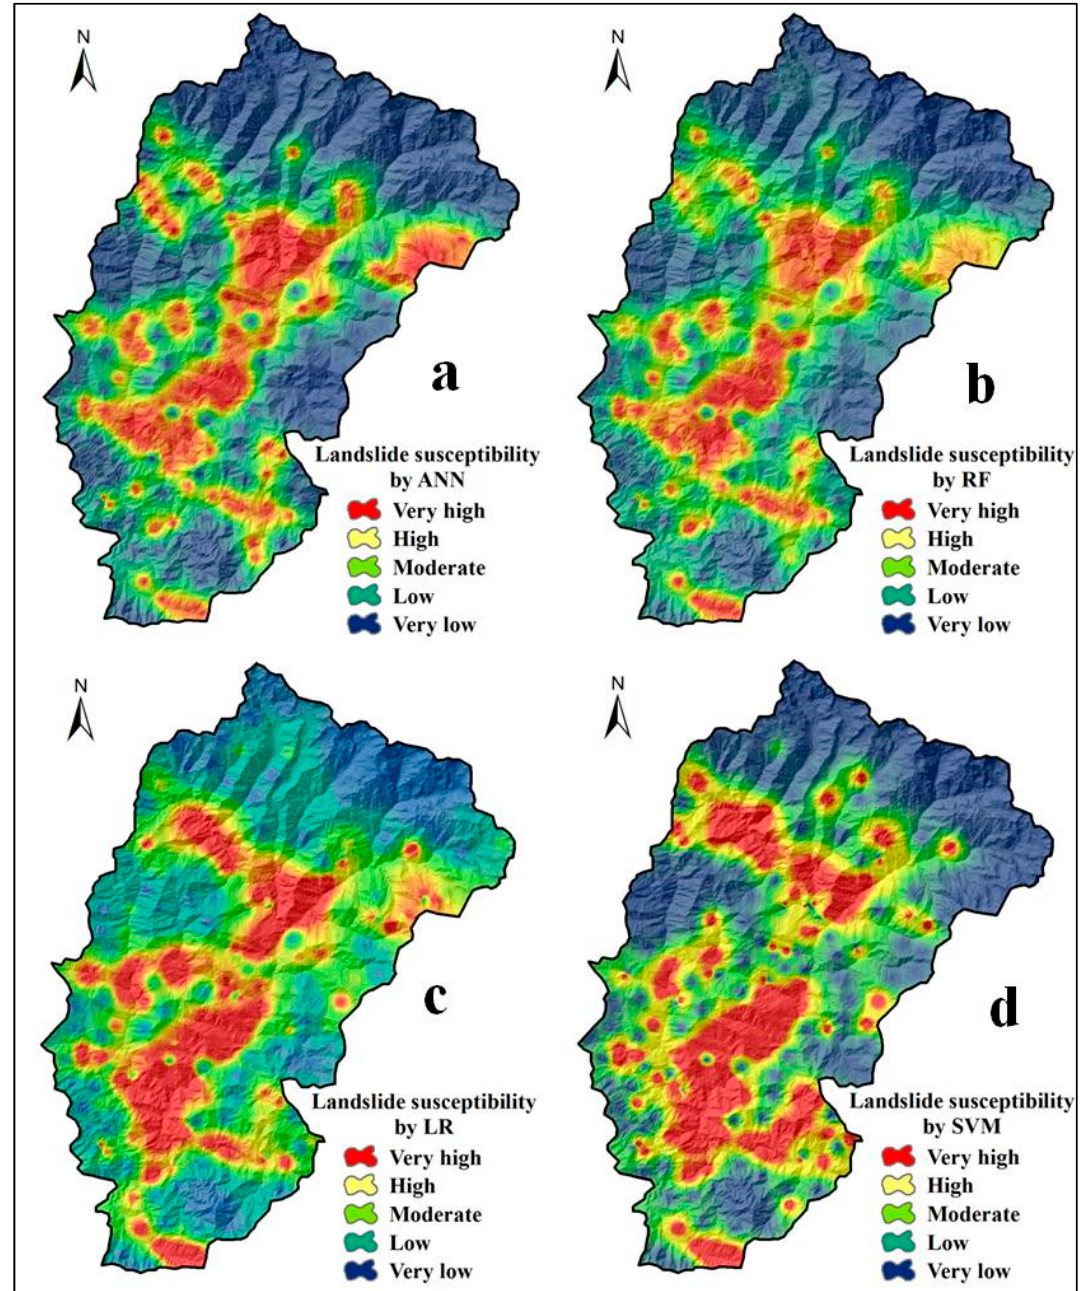
Figure 5. Landslide susceptibility mapping using single models: ( a ) ANN ( b ) RF, ( c ) LR and ( d ) SVM.